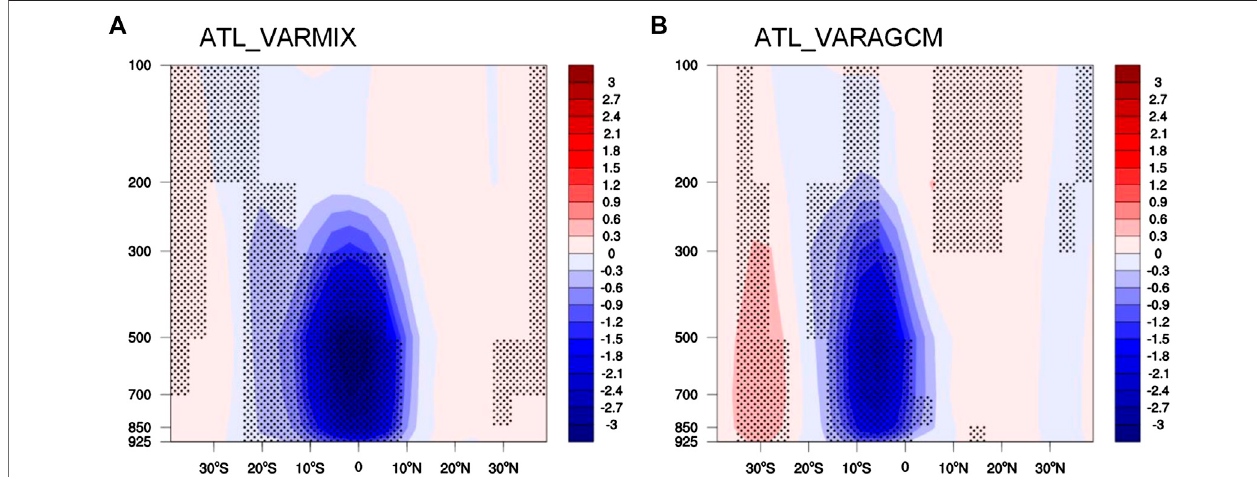
FIGURE6| TheHadleycirculationmassstreamfunction(10 8 kg s − 1 )regressed onthenormalizedAMVindexinthe (A) ATL_VARMIXandthe (B) ATL_VARAGCM for 1900 – 2013. Dotted shading indicates the regression coef fi cients signi fi cant at the 95% con fi dence level.